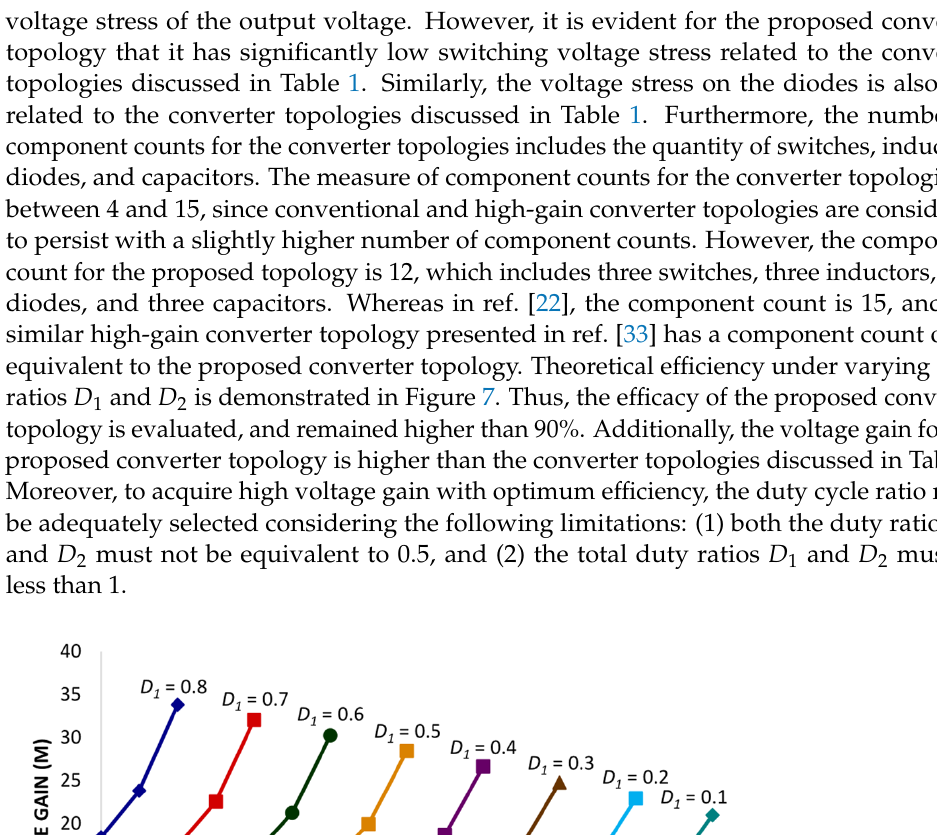
Figure 5 . Voltage gain comparison among various recently proposed DC–DC converters.